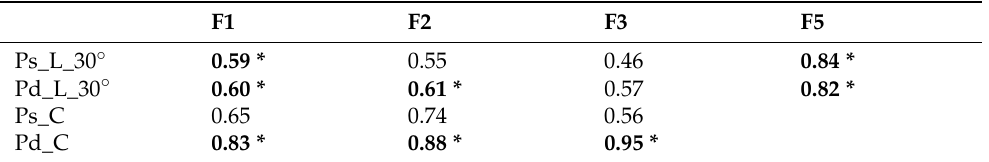
Figure 7. Relationships between the soil moisture and the mean values of Ps and Pd at L-band over F1, F2, F3, and F5 sites. The error bars represent the standard deviation of Ps and Pd within each forest site. Table 9. Correlation coefficients between the soil moisture and the mean values of Ps and Pd at L and C- bands over F1, F2, F3, and F5 sites. Significant correlations ( p -value < 0.05) are denoted with